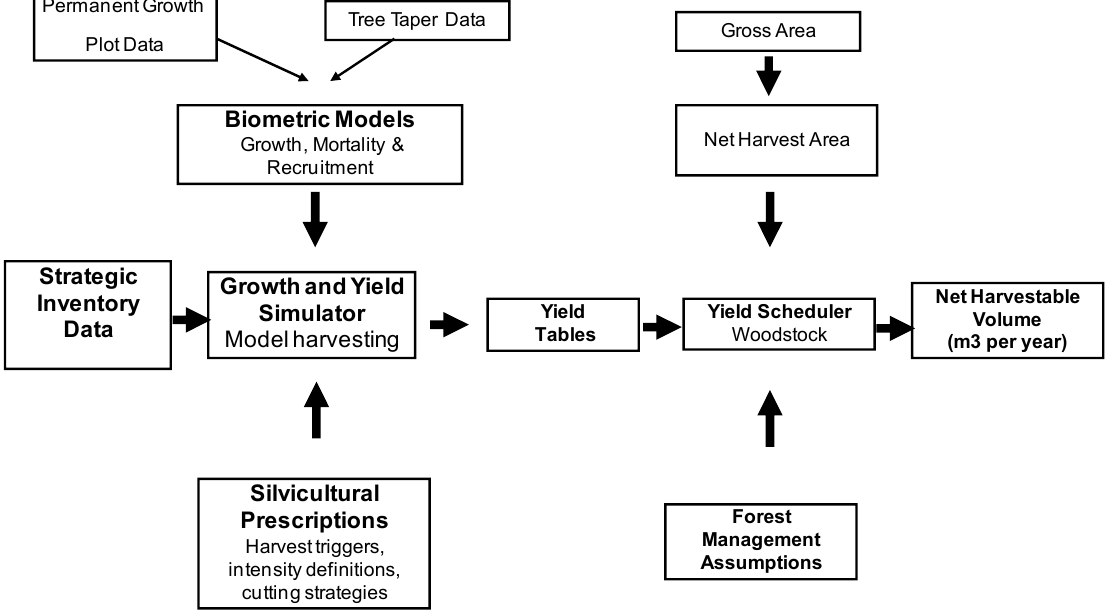
Figure 3. FRAMES (Forest Resource and Management Evaluation System) Toolkit information flow.